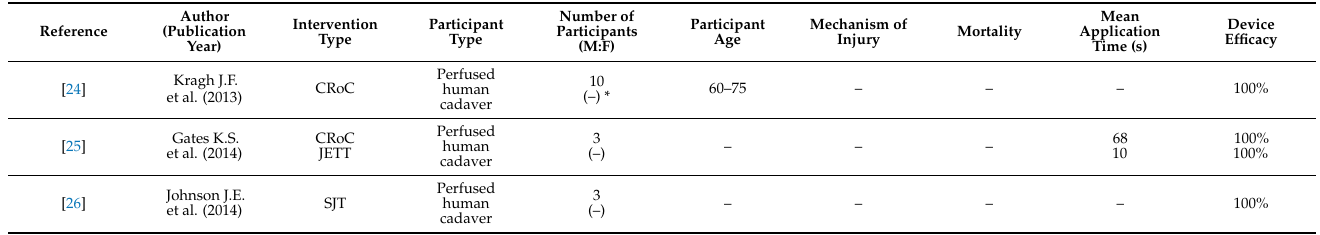
Table 3. Summary of junctional tourniquet study characteristics, patient demographics, and outcome measure results in perfused human cadaver studies.